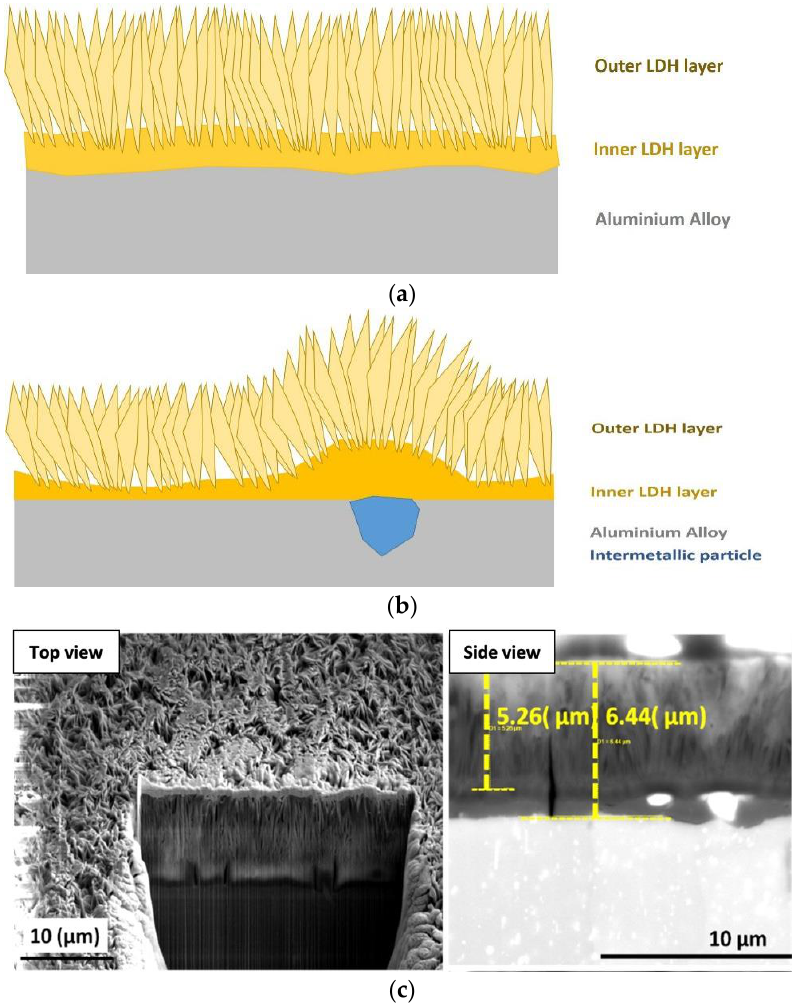
Figure 3. Structure of LDH based coatings: ( a ) schematic representation of the structure of the film; ( b ) schematic representation of the structure of the film in presence of intermetallic particles; ( c ) FIB-SEM image of MgAl-LDH coating on AA6082 (courtesy of Jönköping University).